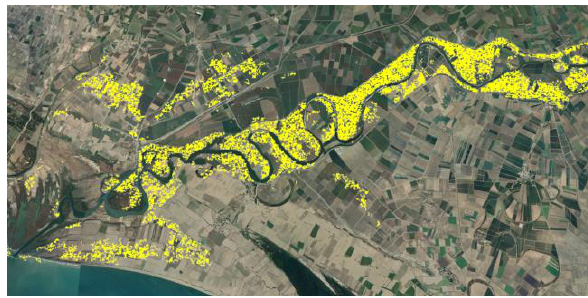
Figure 5. Bare soil zone affected by the flood